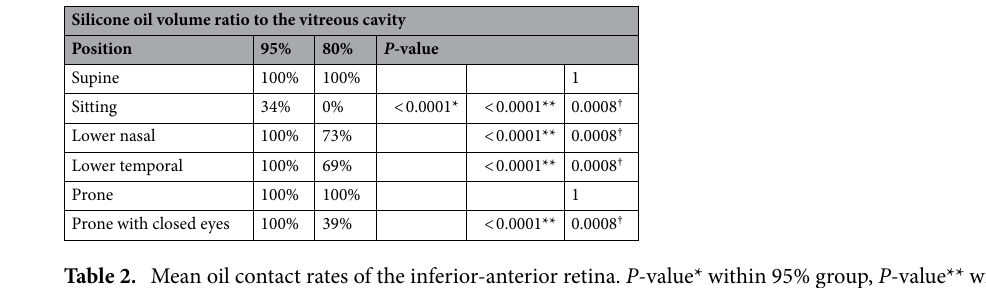
Table 2. Mean oil contact rates of the inferior-anterior retina. P -value* within 95% group, P -value** within 80% group, P -value † at 95% oil versus at 80% oil.